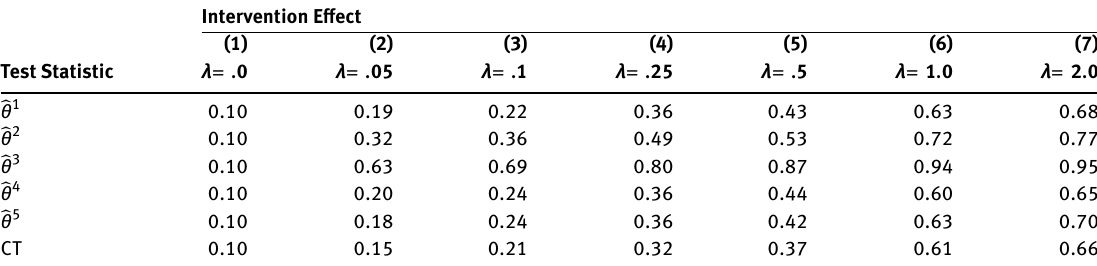
Table 1: Monte Carlo Experiment’s Rejection